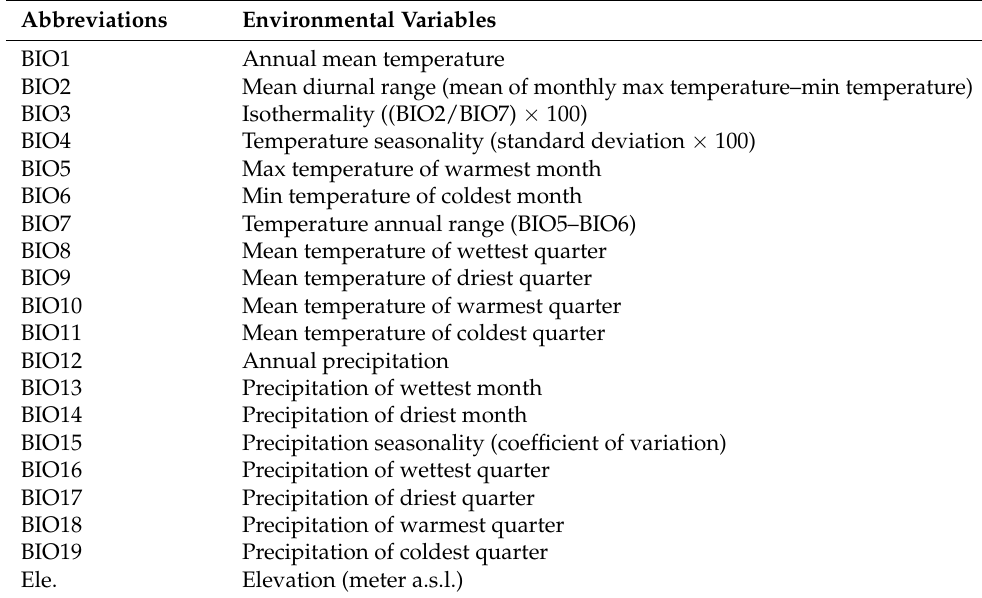
Table 1. Environmental variables and elevation information that may shape species